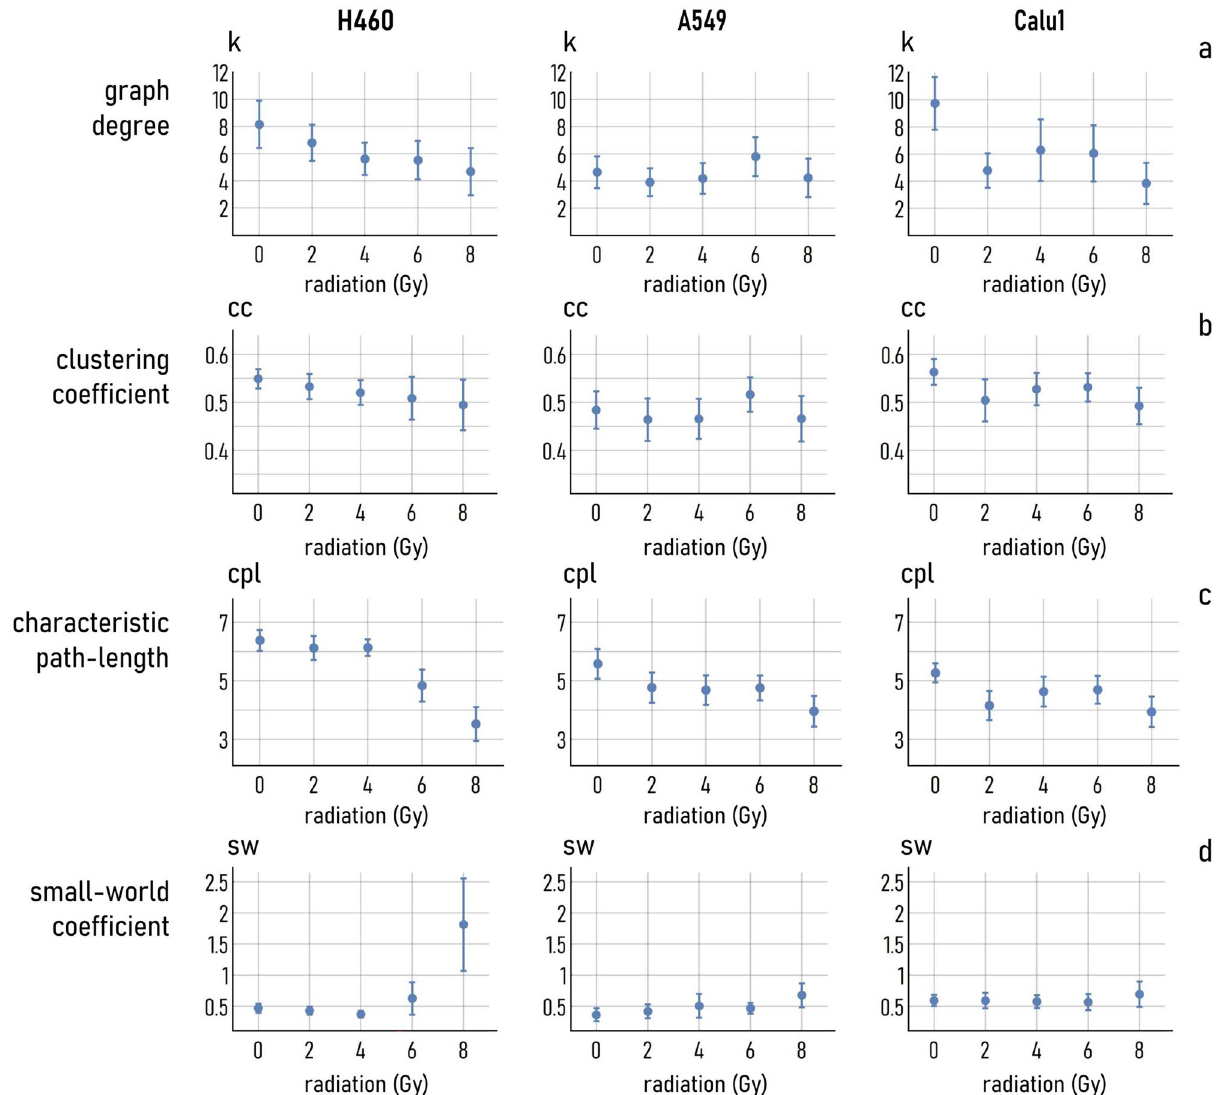
Figure 4. The degree of a graph k ( a ), clustering coefficient cc ( b ), characteristic path length cpl ( c ) and small- world coefficient SW ( d ) of the cell-graphs obtained by linking cell centers through the Waxman algorithm are